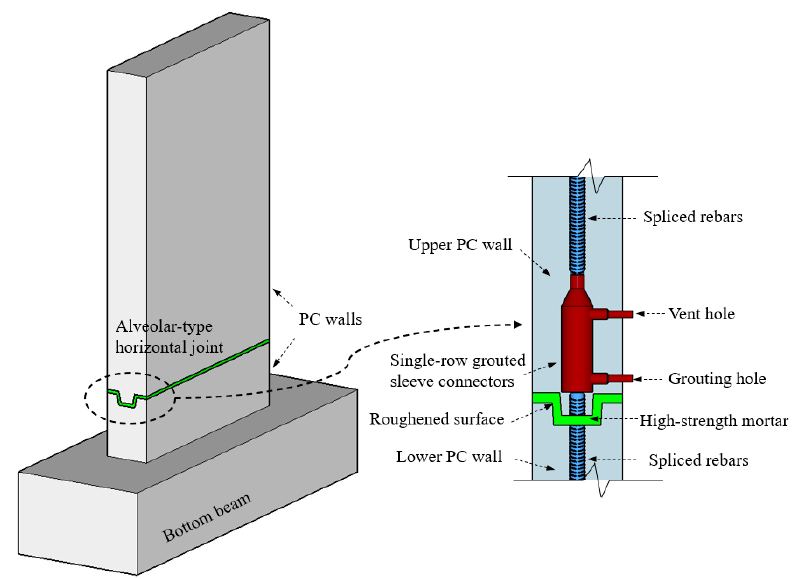
Figure 1. Schematic diagram of the horizontal alveolar-type joint.